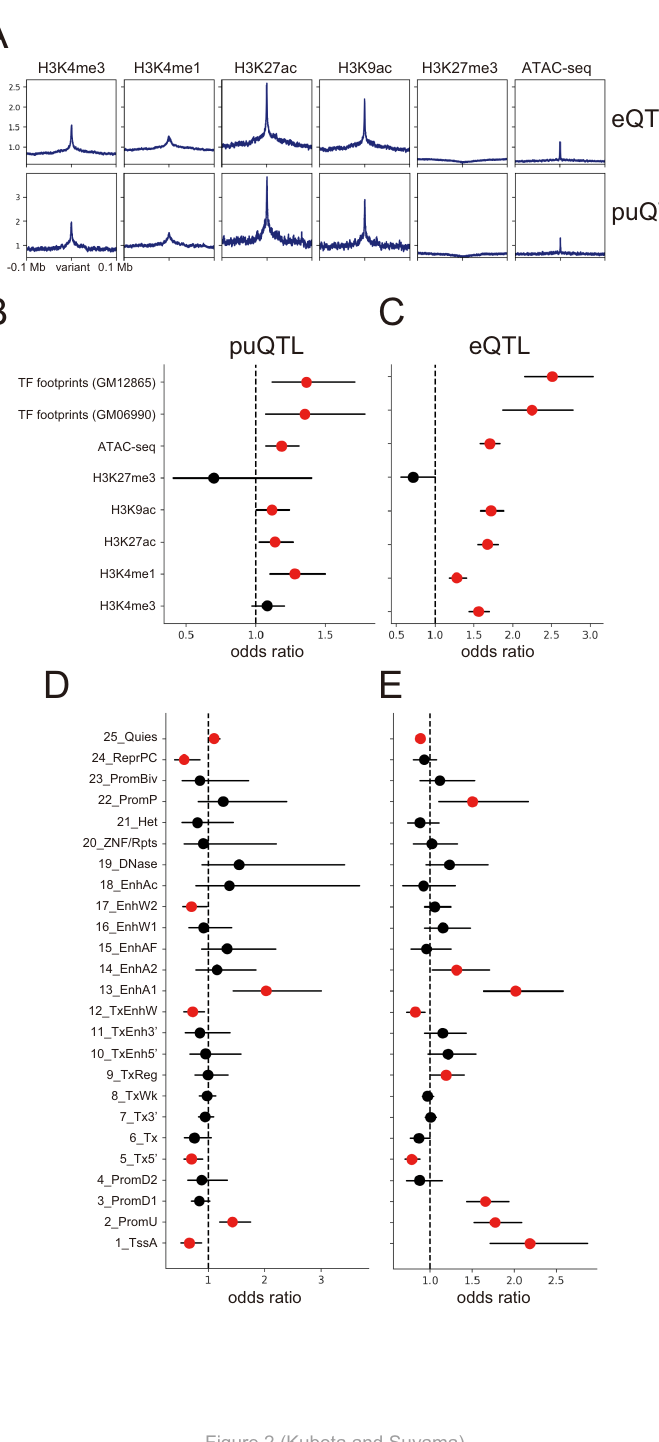
Fig 2. Enrichment of epigenetic features. (A) Aggregation plots of histone mark ChIP-seq and ATAC-seq signals for the 100 kb regions flanking puQTL best hit variants. (B–E) Enrichment of the peaks of histone mark ChIP-seq and transcription factor footprints at puQTL (B) and eQTL (C), and enrichment of the chromatin states defined by ChromHMM at puQTL (D) and eQTL (E). The red dots represent significant enrichment at the 5% FDR level, and the bars indicate 95% confidence